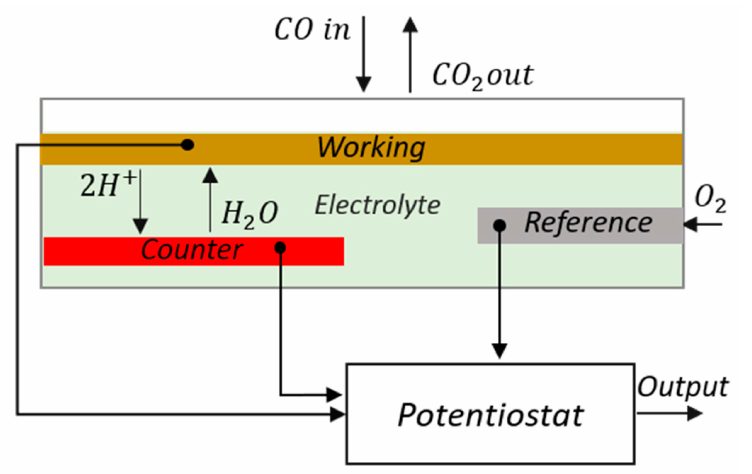
Figure 11. Operating principle of an electrochemical sensor for CO detection. Reproduced from [69].